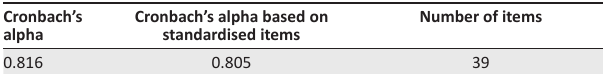
TABLE 1: Reliability statistics